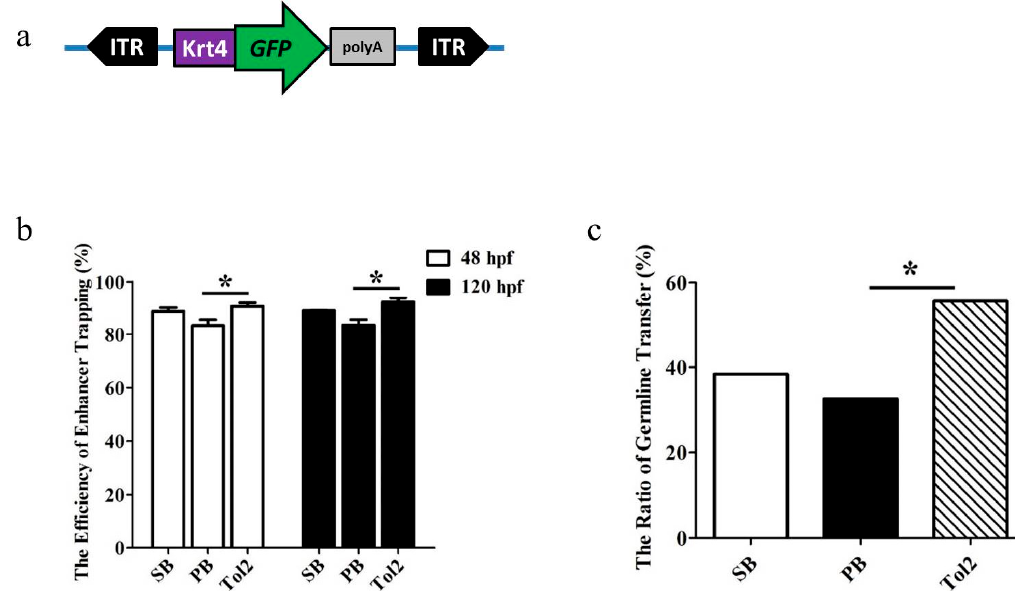
Figure 1. Green fluorescent protein (GFP) expression efficiency and germline transfer efficiency of enhancer trapping (ET) based on sleeping beauty ( SB ), piggyBa ( PB ) and Tol2 transposons in zebrafish. ( a ) Schematic of the transposon-based ET cassette (not to scale). The cassette includes two inverted repeat sequences ( SB , PB , or Tol2 inverse terminal repeats (ITRs)), and a minimal Krt4 promoter, GFP , and β -globin polyA signal; ( b ) GFP expression efficiency was measured by GFP screen at 48 and 120 h postfertilization (hpf) after co-injection of a fixed amount of transposon plasmid with the corresponding transposase mRNA into zebrafish embryos. The total number of injected embryos was 1378 in SB , 1276 in PB , 1524 in Tol2 . Error bars represent SD; ( c ) germline efficiency was measured by crossing the GFP -positive founders with wild-type (WT) fish. Significant difference was detected using a χ -squared test; asterisk indicates p <